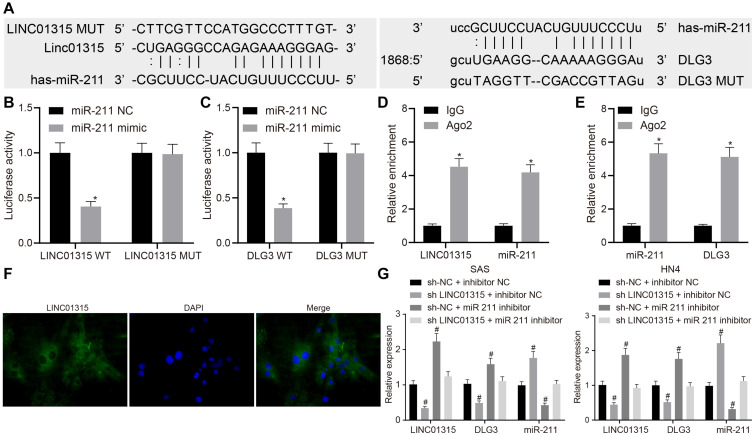
LINC01315 binds to miR-211 and thus upregulates DLG3 expression. (A) miR-211 has a complementary sequence in LINC01315 and DLG3 respectively, found by Blast contrast; (B) Relation between LINC01315 and miR-211 identified using dual-luciferase reporter gene assay; (C) Relationship between miR-211 and DLG3 identified using dual-luciferase reporter gene assay; (D) Binding of LINC01315 to miR-211 verified using RIP assay; (E), Binding of miR-211 to DLG3 verified using RIP assay; (F) Subcellular location of LINC01315 determined using FISH assay. (G) Expression of LINC01315, miR-211 and DLG3 determined by RT-qPCR in OSCC cells transfected with sh-LINC01315/sh-NC and miR-211 inhibitor/inhibitor NC. The data were expressed as mean ± standard deviation and analyzed using one-way ANOVA. *p < 0.05 vs. the miR-211 NC group or the IgG group; #p < 0.05 vs. the sh-NC + inhibitor NC group. The experiment was repeated three times independently.